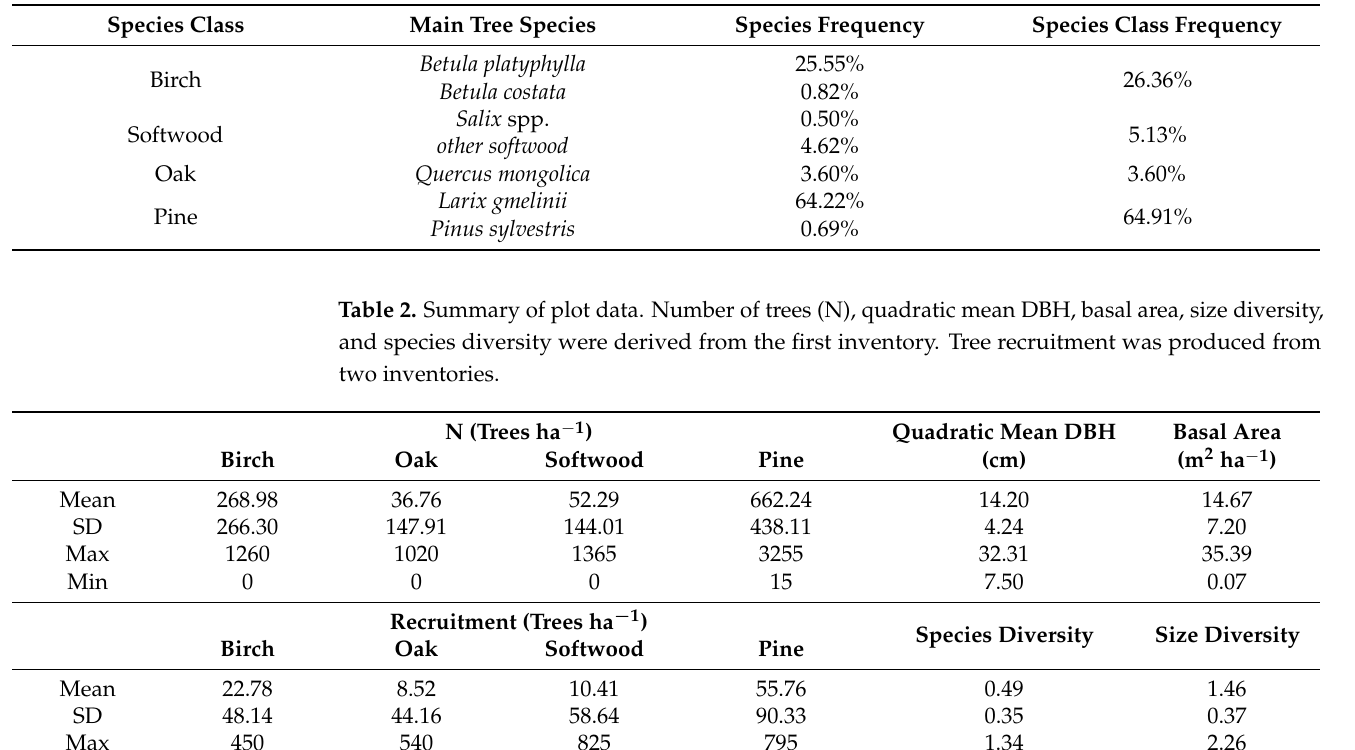
Table 1. The main tree species identified and their frequency in the sample plots.